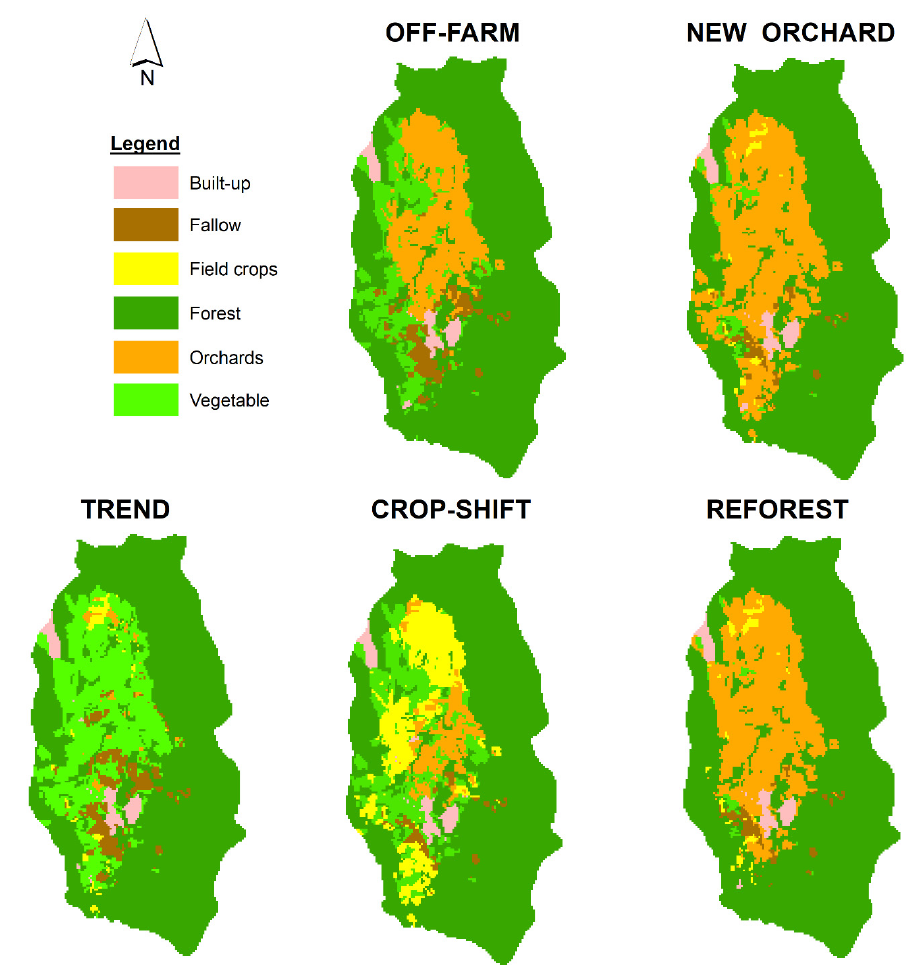
Figure 6. Results of the Dyna-CLUE scenario simulations in 2029 based on outcomes of the land-use change analysis (TREND), stakeholder assumptions (CROP-SHIFT, OFF-FARM) and institutional visions (NEW ORCHARD, REFOREST).